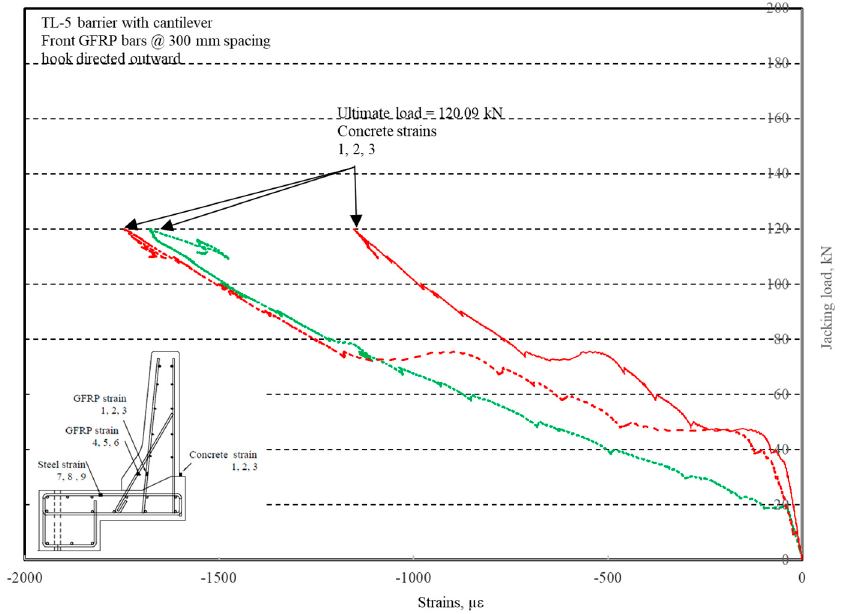
Figure 17. Specimen # 2: Load vs. concrete strain history.